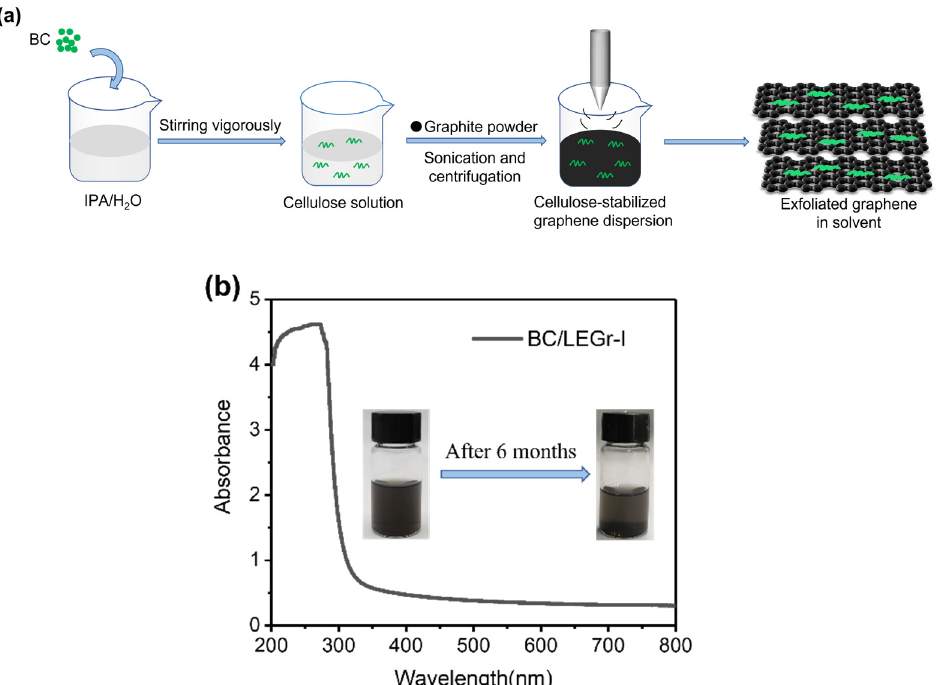
Figure 1. ( a ) Schematical illustration of BC-stabilized few layer graphene dispersions through BC/solvent assisted liquid phase exfoliation (LPE). ( b ) UV-Vis spectra of BC/LEGr-I dispersion and inset of BC/LEGr-I dispersion standing for six